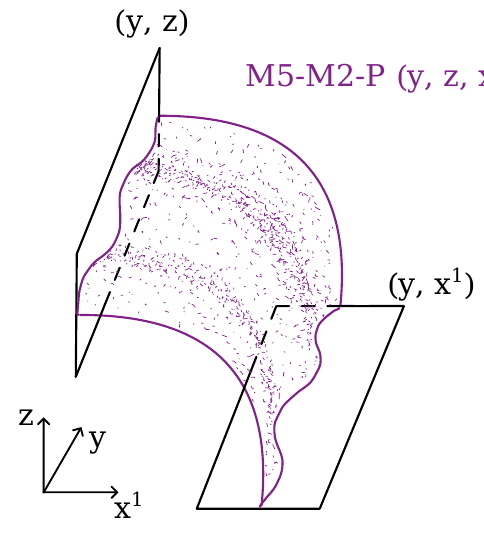
Figure 6 . Wiggling